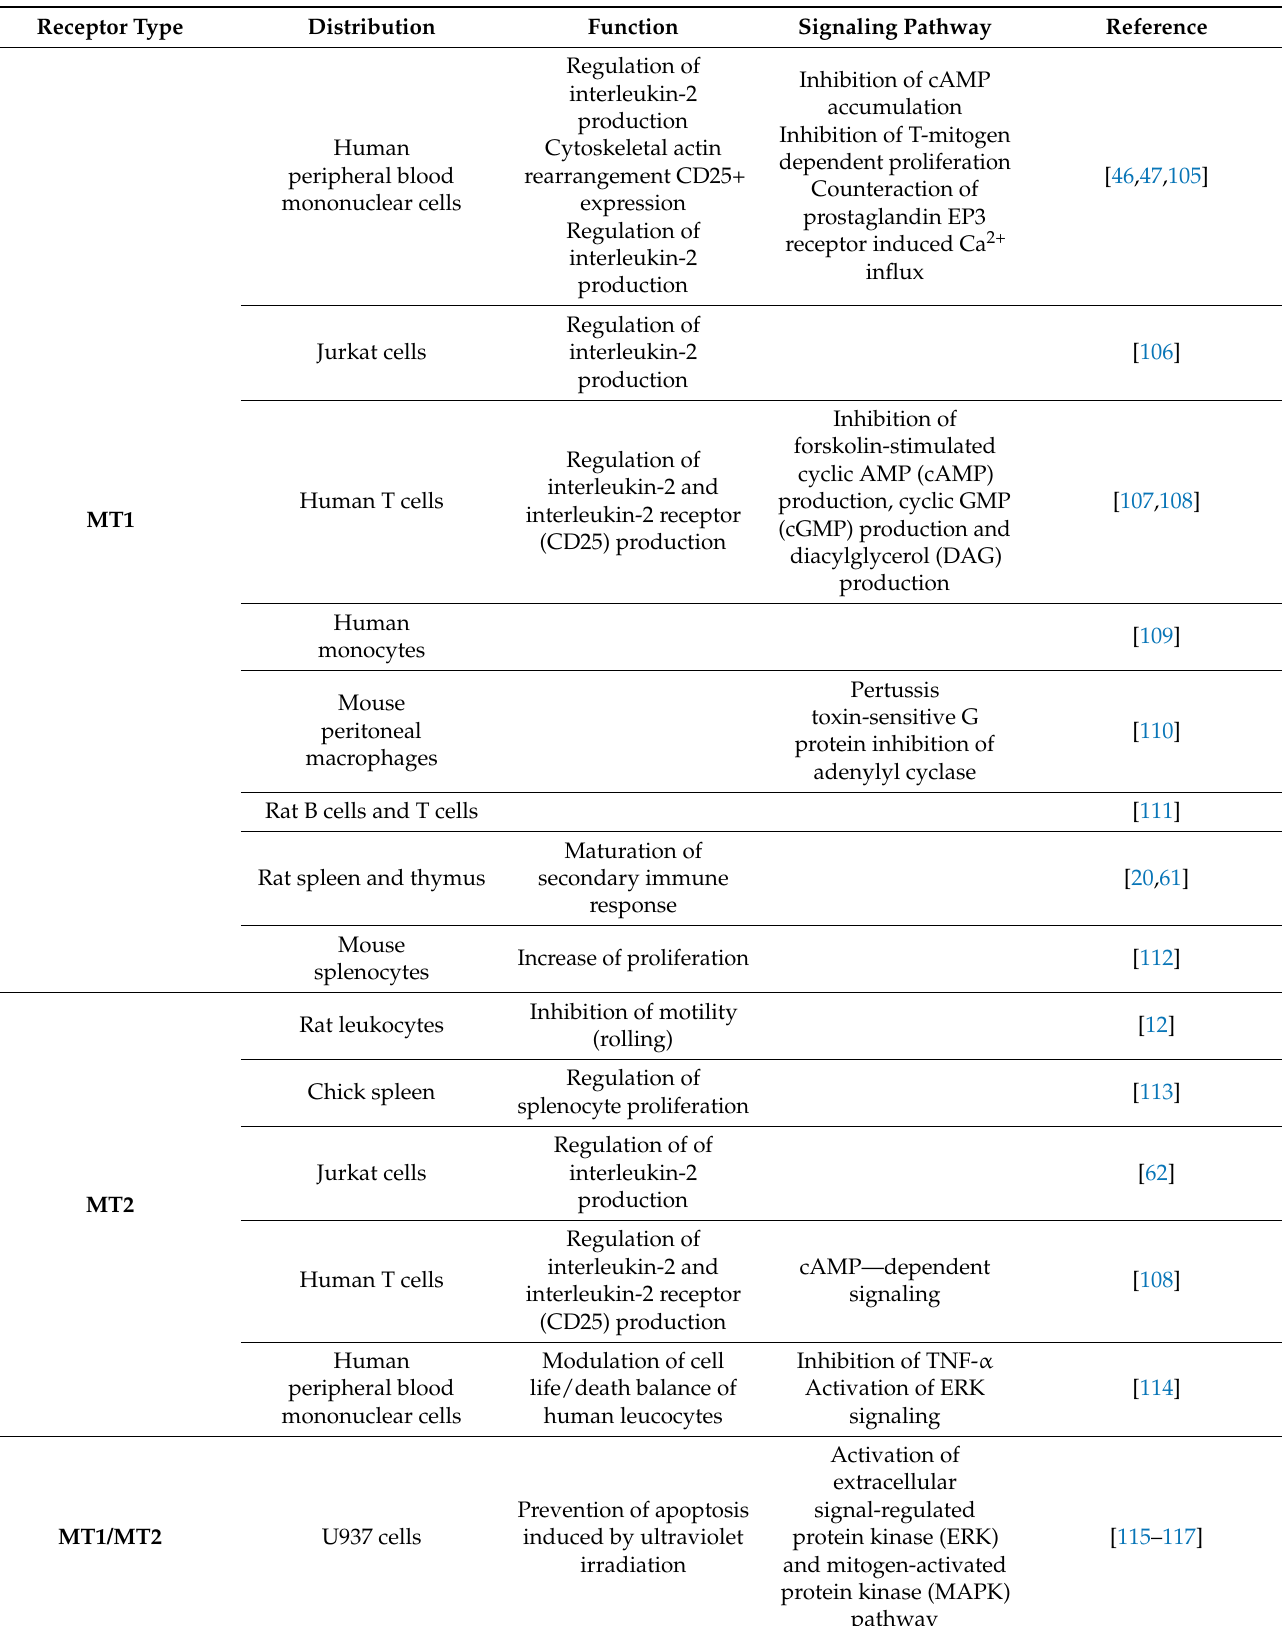
Table 1. Distribution and function of MT1 and MT2 in the immune system